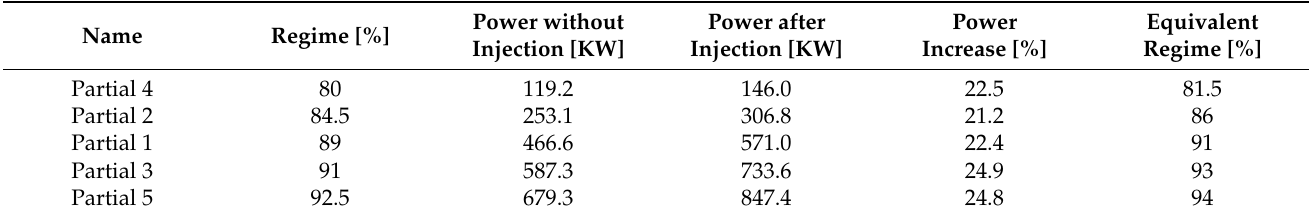
Figure 12. Turbine working line with and without injection. Table 6. Partial regimes analysis